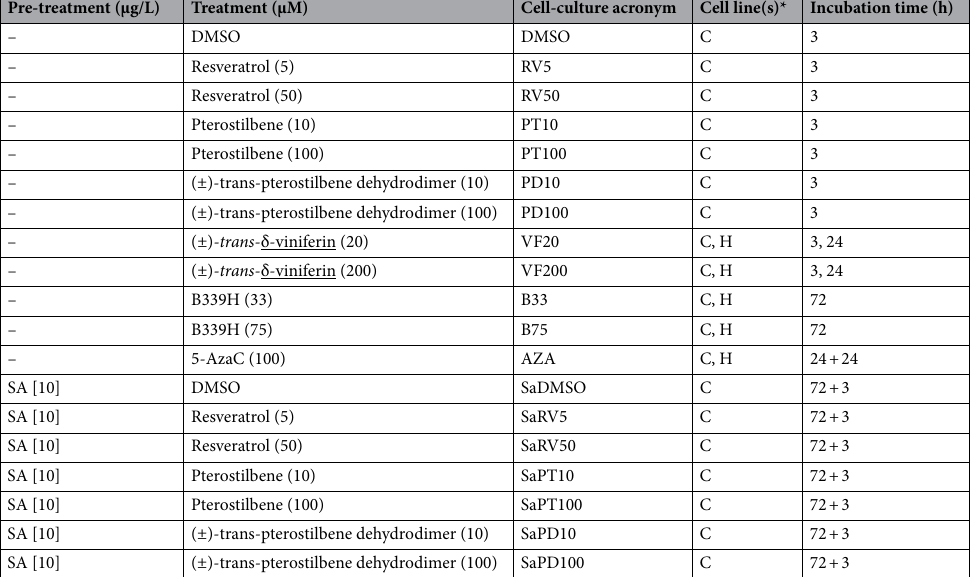
Table 5. Cell cultures/treatments planning. C Caco-2 cells, H HepG-2